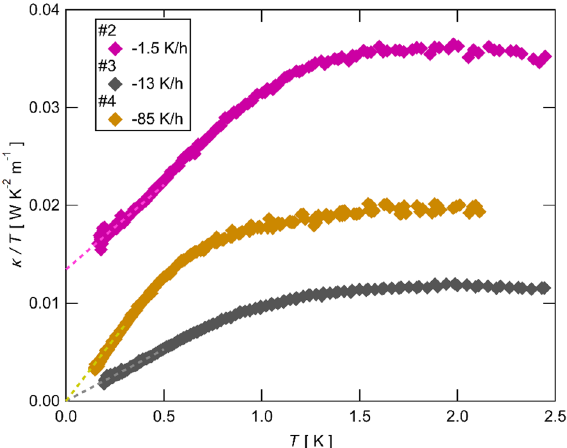
Figure 2. The temperature dependence of the thermal conductivity divided by the temperature ( κ/ T ) of Sample #2, #3 and #4. The data of Sample #2 and #3 is the same data in Ref. 21 . The dashed lines show a linear fit of the data at lower temperatures.